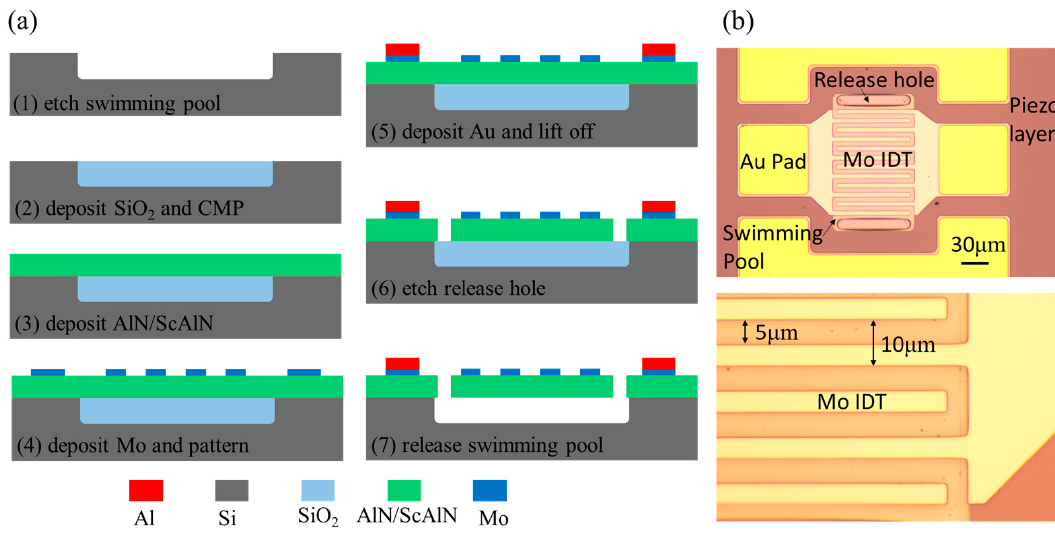
Figure 6. ( a ) The process flow of LWR with composite piezoelectric layers. ( b ) The optical image of fabricated LWR device.